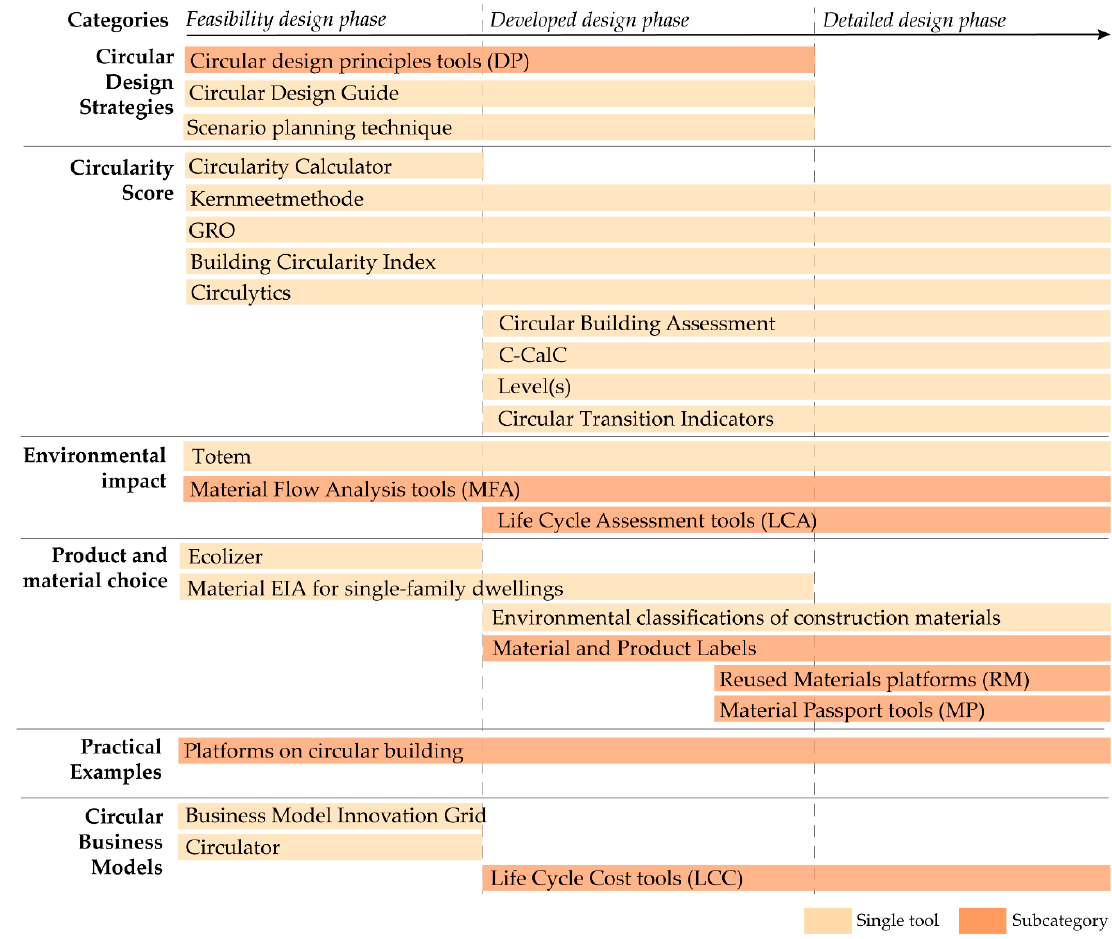
Figure 2. Framework 1: Categorisation of the design support tools for circular building per design phase and per design tool category. Tools that serve the same purpose and have the same target audience are further clustered in subcategories (darker bars).